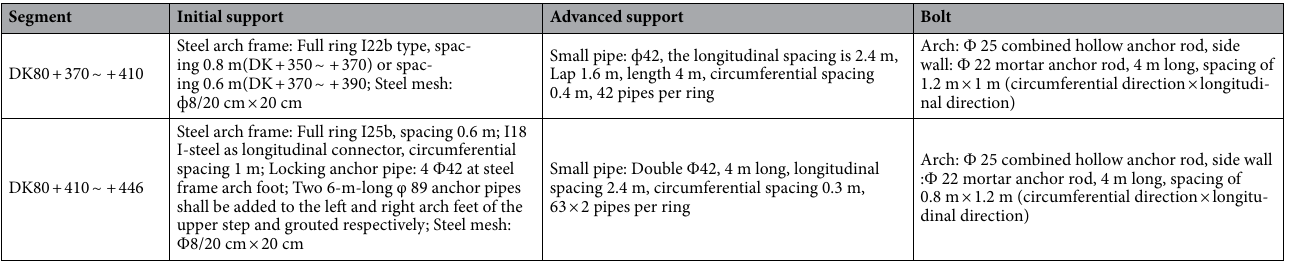
Table 2. Parameters for the tunnel support